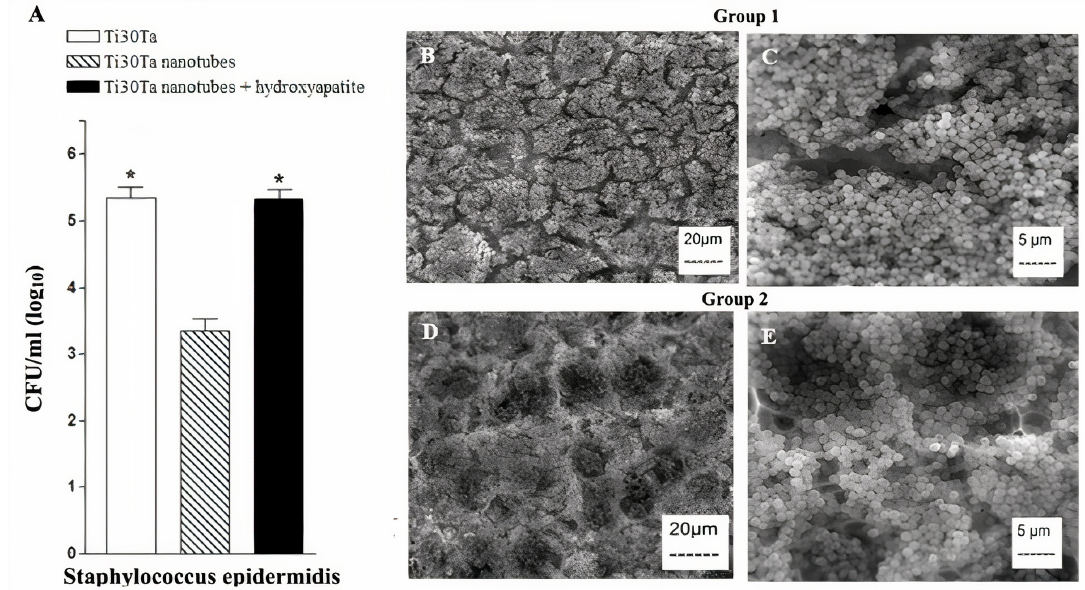
nanotube) and Group 2 (TiO nanotube + hydroxyapatite); a) graphic relationship of CFU/ml Figure 4. SEM images of Group 1 (TiO 2 2 for each group, b) image with lower magnification for Group 1, c) image with higher magnification for Group 1, d) image with lower magnification for Group 2, e) image with higher magnification for Group